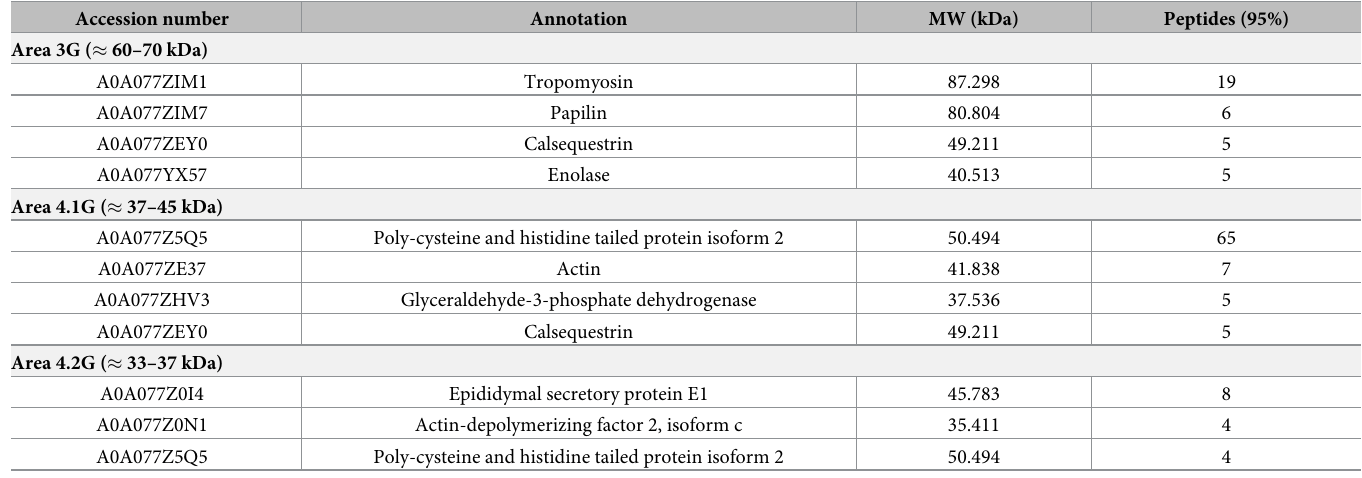
For the FE, the comparative study for the specific immune-complexes identified by Western blot (Fig 2, Lane 3) and areas matched on SDS-PAGE gels (Fig 2, Lane 4) were also excised and analyzed by LC-MS/MS and presented in Table 4. With the FE as antigen these ranged from 33 to 70 kDa with the most immunogenic in two distinct bands, band 3W ( � 60–70 kDa) (Fig 2, Lane 4) and band 4W ( � 37 kDa) (Fig 2, Lane 3). Based on corresponding molecular weights in the EE proteome, band 1W contained vitello- genin N and VWD and DUF1943 domain containing protein (VgNVD) with 205 distinct pep- tides and heat shock protein 70 (HSP-70) with 21 distinct peptides (Table 2). Confirmatory LC-MS/MS of the corresponding Coomassie-stained band confirmed that VgNVD, with 241 distinct peptides, was the most representative protein within the 1W area (Table 3). Table 4. Protein identities, in decreasing abundance within FE excised gel areas (3G, 4.1G, 4.2G) with suitable MW matching Western blot band areas 3W and